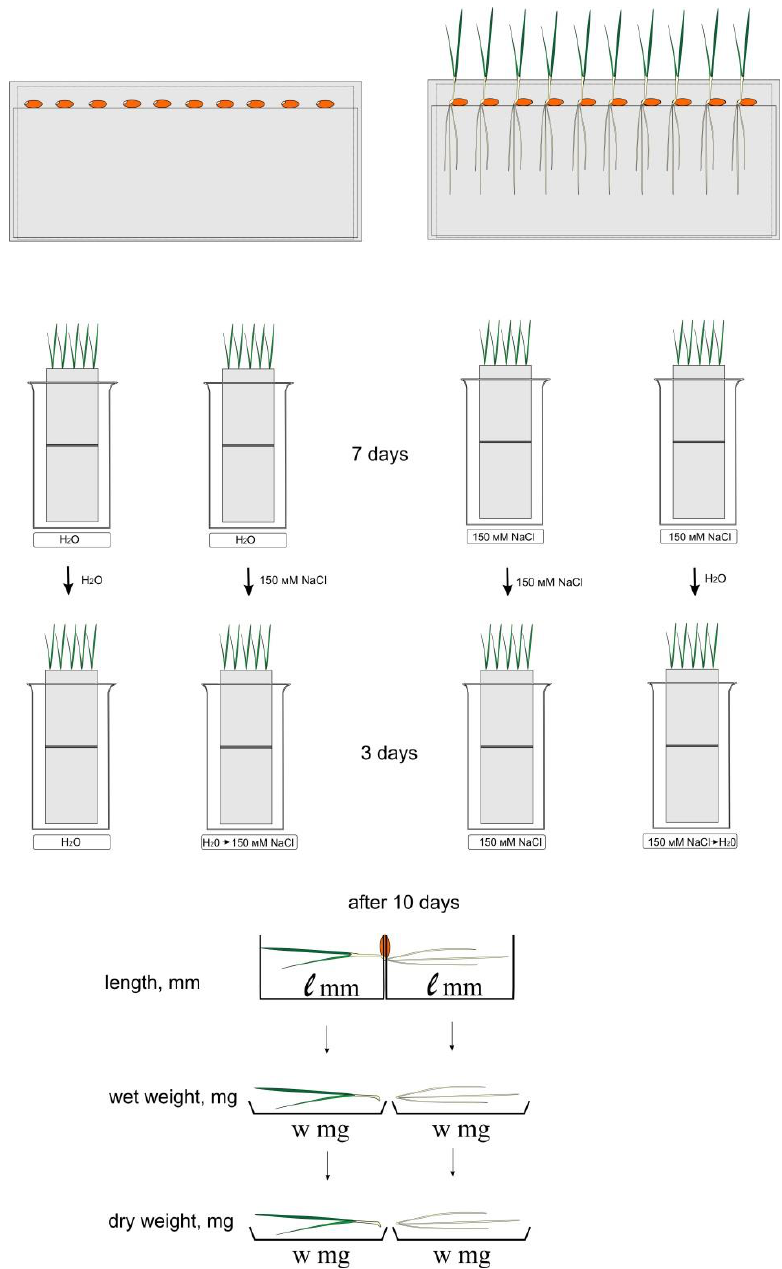
Figure 1. Experimental scheme. Paper rolls were cultivated in distilled water and 150 mM NaCl. After 7 days of cultivation, half of the rolls were transferred to other conditions: rolls with water were transferred to 150 mM NaCl, and rolls from 150 mM NaCl to water. The cultivation of all rolls continued for another 3